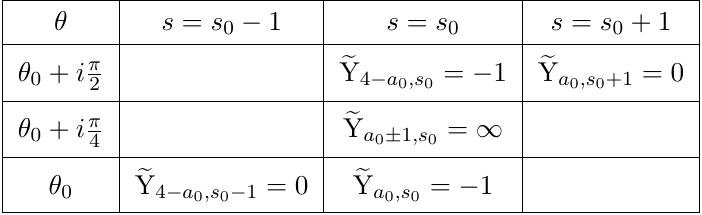
1 , s + 1 } are not 0 − 0 , s 0